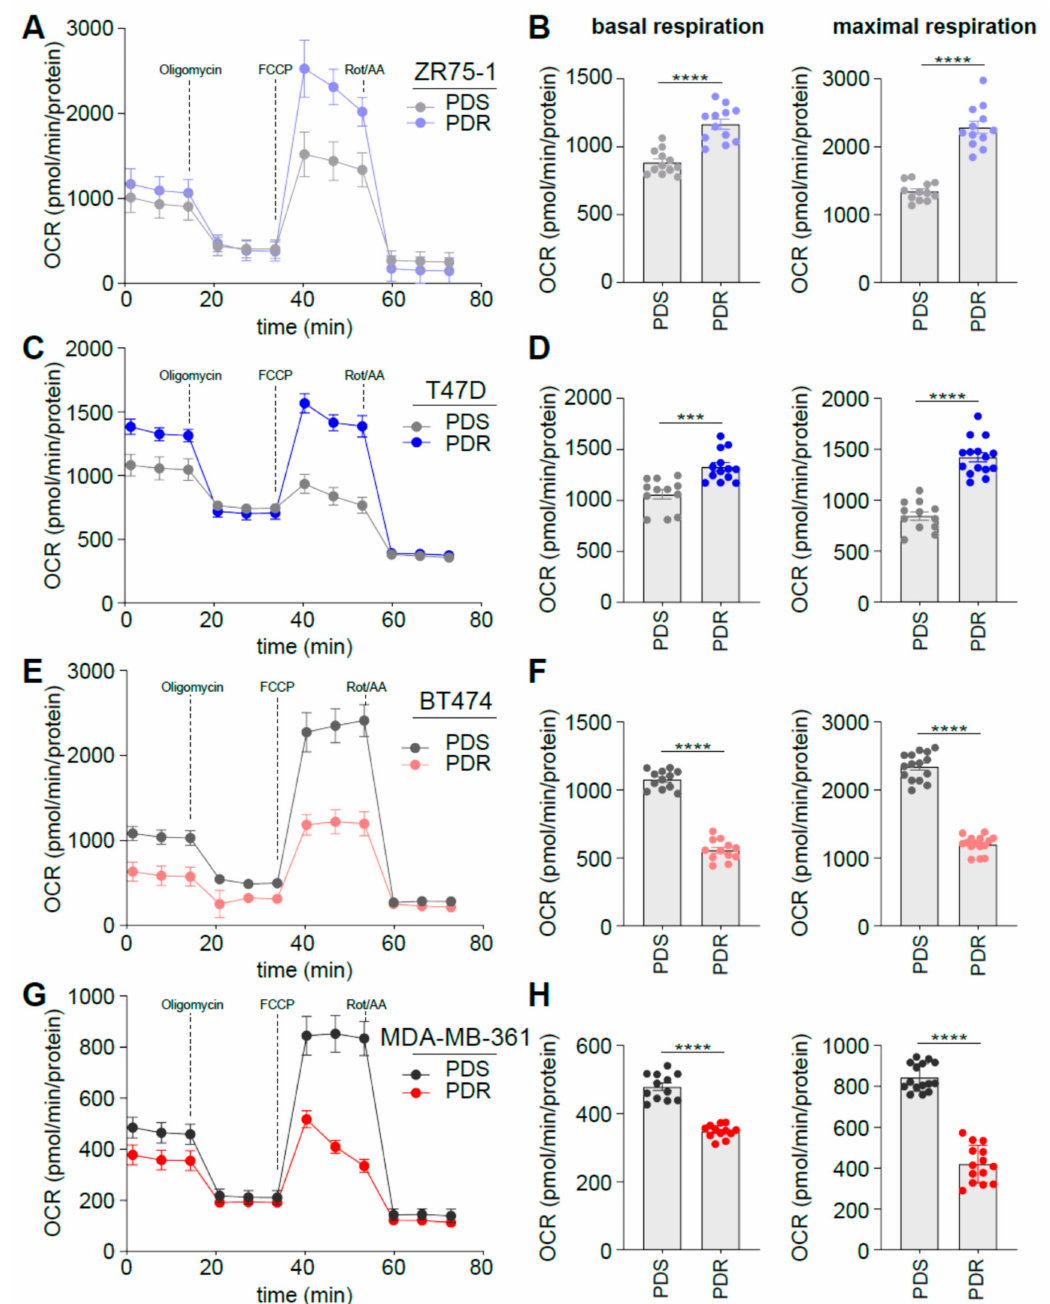
Figure 4. HER2 status impacts on glucose dependent oxidative phosphorylation in palbociclib resistance. ( A , C , E , G ) PDS and PDR cells were subjected to Seahorse XFe96 Mito Stress Test analysis and OCR was measured in real time and normalized on protein levels. ( B , D , F , H ) Basal and maximal respiration was calculated as described in Method Details, based on the OCR after the administration of the adenosine triphosphate ATP synthase inhibitor oligomycin, the proton uncoupler carbonilcyanide p-triflouromethoxyphenylhydrazone (FCCP), and the respiratory complex I inhibitor rotenone, together with the respiratory complex III inhibitor antimycin A. Each dot represents at least three technical replicates from three biological replicates. Data represent means ± SEMs. One-way ANOVA; Dunnett’s corrected; *** p < 0.001; **** p <